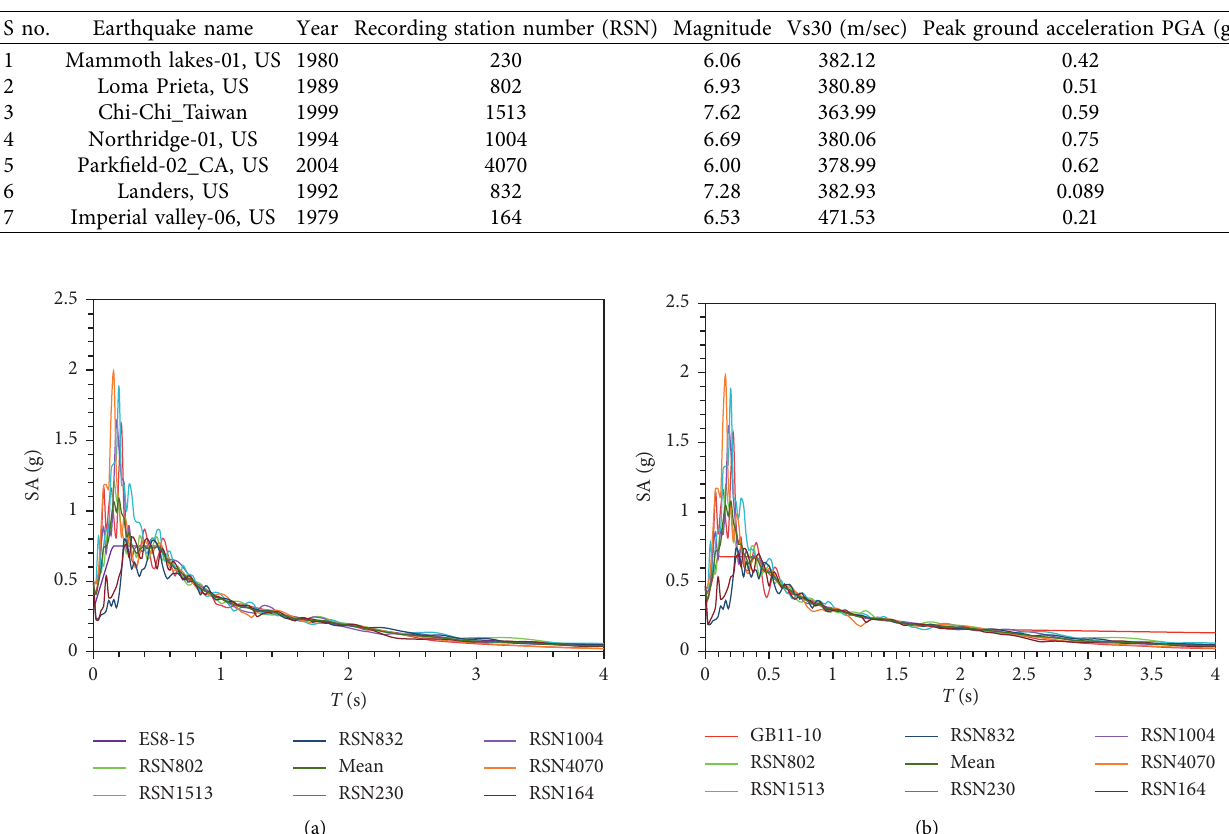
Table 4: PEER ground motion data NGA West-2.